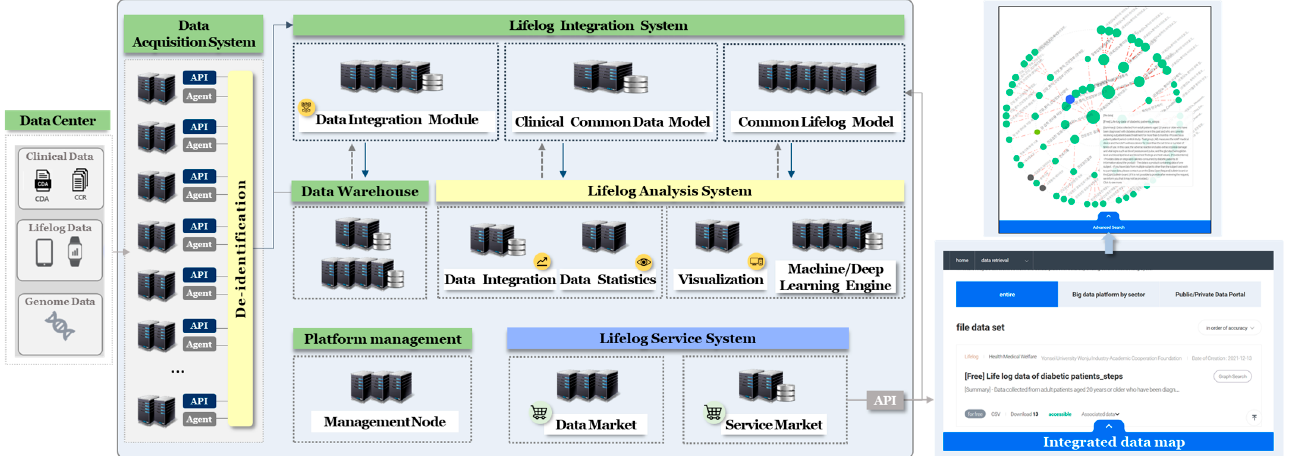
Figure 1. Lifelog-based digital healthcare platform.